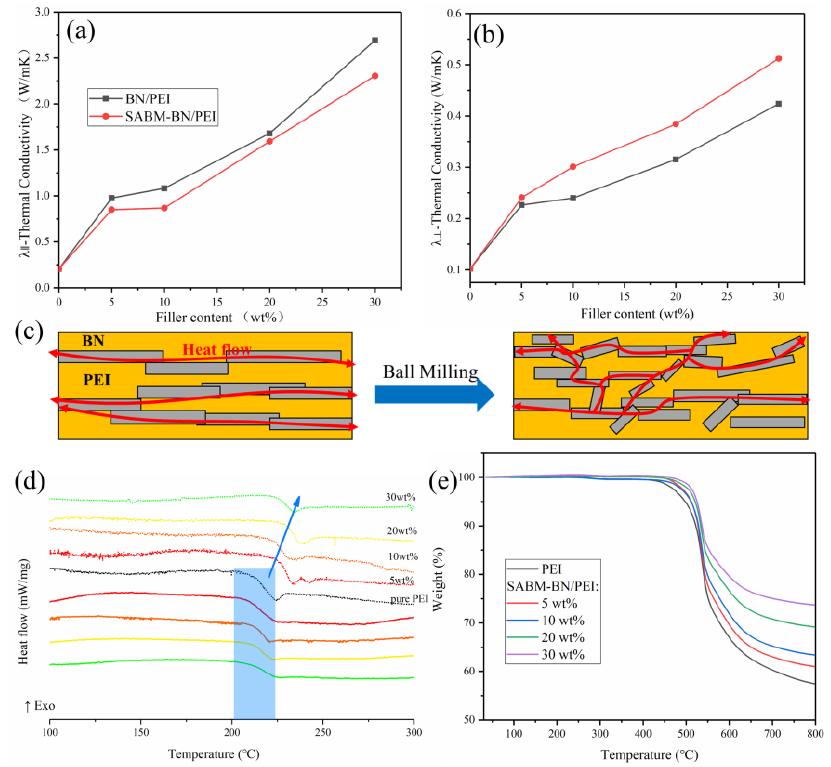
Figure 3. ( a ) In-plane and ( b ) through-plane thermal conductivity of PEI and the PEI composite films and ( c ) a heat conduction model. ( d ) DSC curves of PEI, the SABM-BN/PEI composite films (dashed line), and the pre-ball-milling BN/PEI composite film without sucrose (solid line). ( e ) TG curves of PEI and the SABM-BN/PEI composite films.